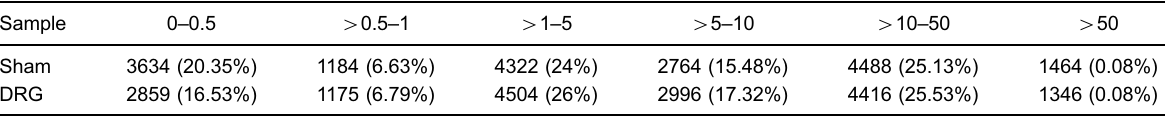
Table 4. Number and percentage of known gene expression.